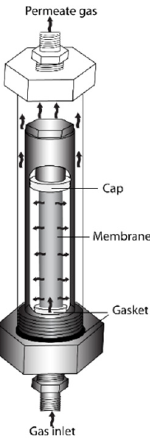
Figure 1. He permeator cell used for the determination of He permeance of the various membranes at room temperature and different transmembrane pressures.